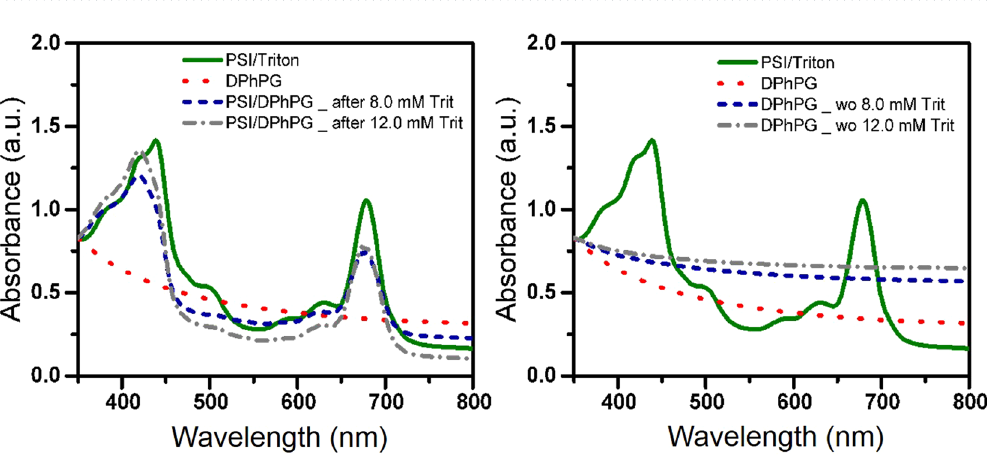
Figure 6. Room temperature absorption spectra of DPhPG liposomes, solubilized PSI and PSI- proteoliposomes with left panel indicating PSI/DPhPG reconstituted at different point of second stage of solubilization and right panel indicating DPhPG liposome suspensions after detergent